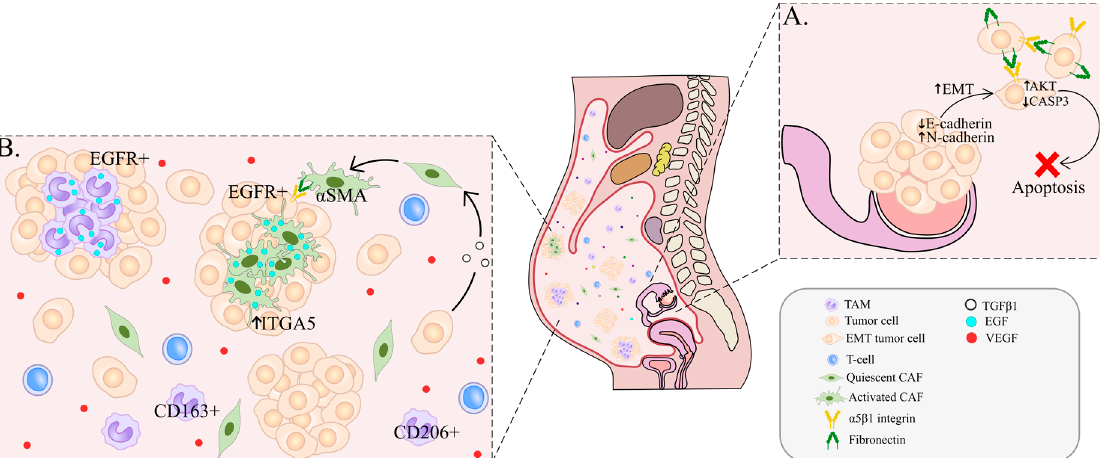
Figure 1. Tumor cell survival and spheroid formation in malignant ascites. ( A ). Downregulation of E-cadherin and upregulation of N-cadherin leads to EMT and a loss of cell–cell contact between tumor cells, followed by their detachment from the primary site. In order to evade anoikis, tumor cells form clusters through α 5 β 1 integrin and fibronectin interactions. Activation of AKT leads to inhibition of caspase-3, which also hinders apoptosis. ( B ). One of the possible mechanisms of spheroid formation is mediated by the EGF-EGFR axis between TAMs/CAFs and tumor cells. Fibroblasts secrete EGF that upregulates ITGA5 expression in tumor cells as well as TGF β , leading to strengthened tumor–stromal interaction inside spheroids. In turn, CAFs activated by TGF β - and ITGA5 -overexpressing tumor cells secrete EGF and other TGF β -associated factors. EGF+ TAMs induce EGFR+ tumor cell migration and spheroid formation. Free-floating TAMs abundantly express CD206 and CD163 in ascites. A major marker for CAFs is α -SMA. VEGF is a key factor in ascitic